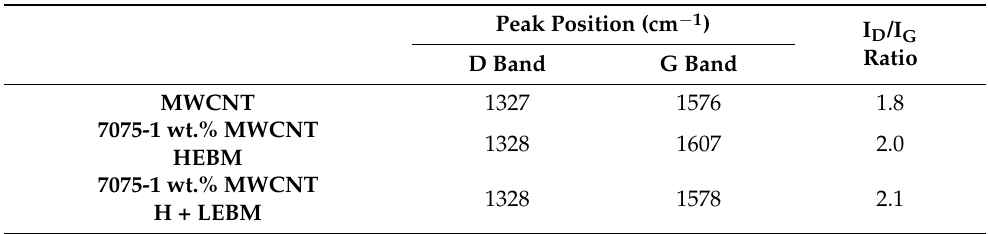
Table 4. D-band and G-band peaks, as well as I D /I G ratio, for as-received MWCNTs and 7075-1 wt.% MWCNT composites obtained by the two proposed milling